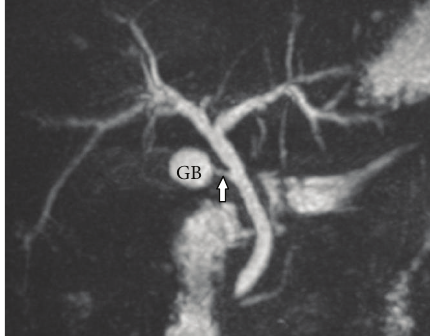
Figure5:Coronaloblique3DMRcholangiopancreatographyshows